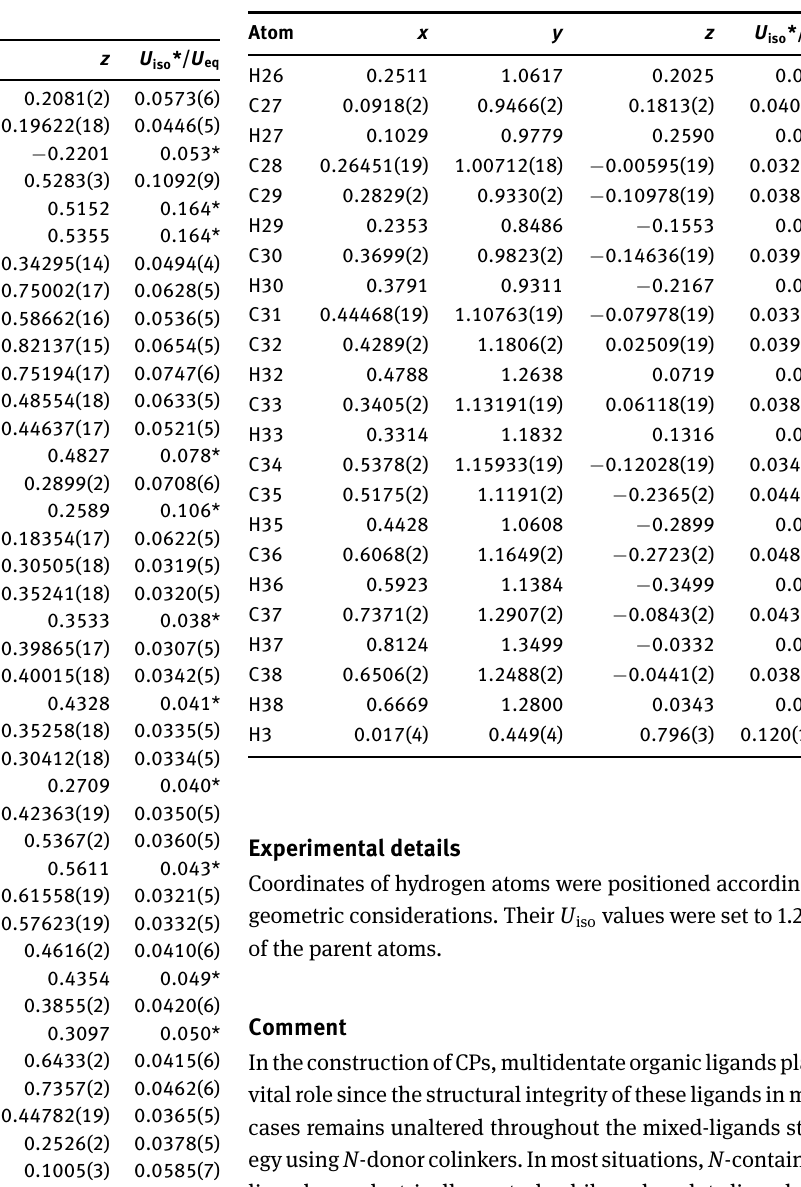
Table 2: Fractional atomic coordinates and isotropic or equivalent isotropic displacement parameters (Å 2